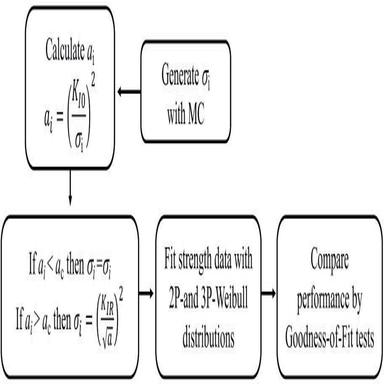
Algorithm of data generation with MC including R-curve effect.